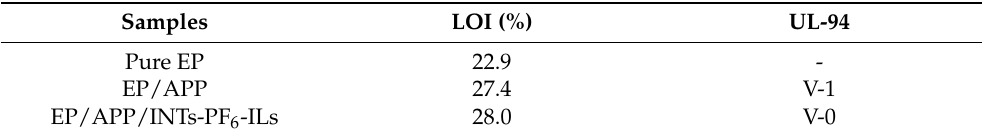
Table 2. LOI and UL-94 rating of EP composites.